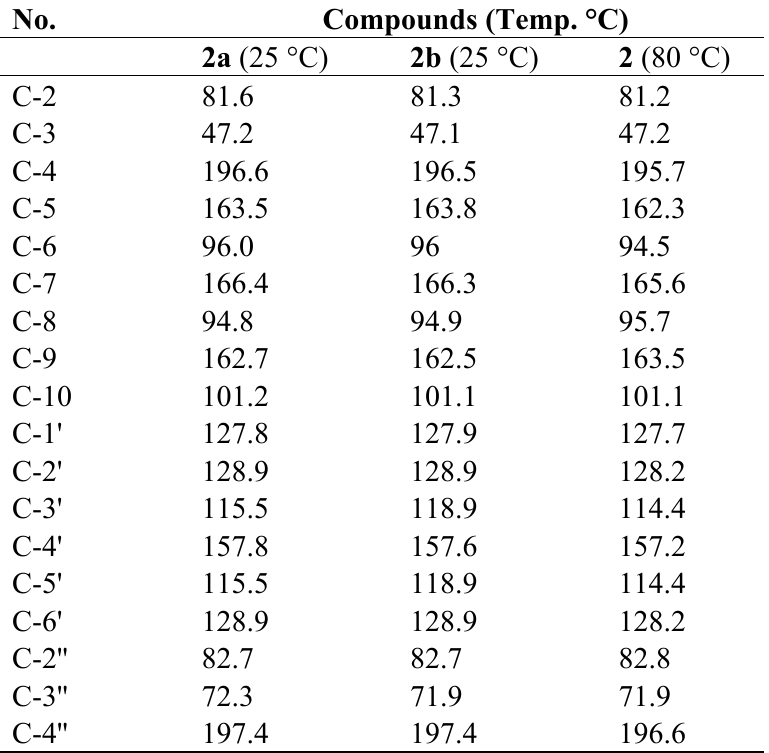
Table 2. 13 C-NMR data of 2 DMSO- d present at 25